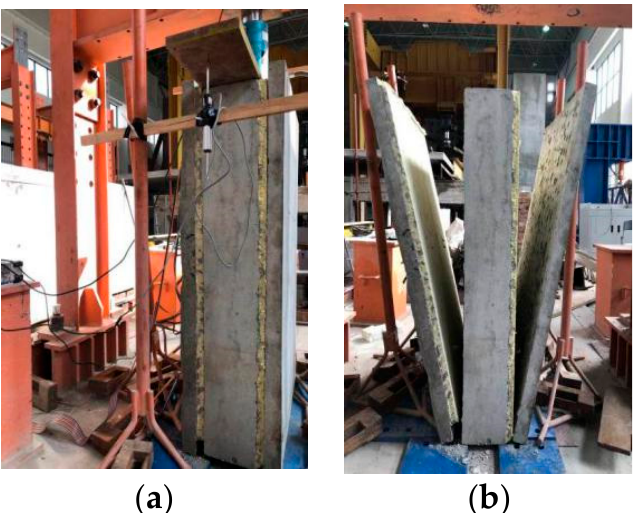
Figure 9. Failure process of wallboard. ( a ) Separation of concrete and insulation; ( b ) final failure result.